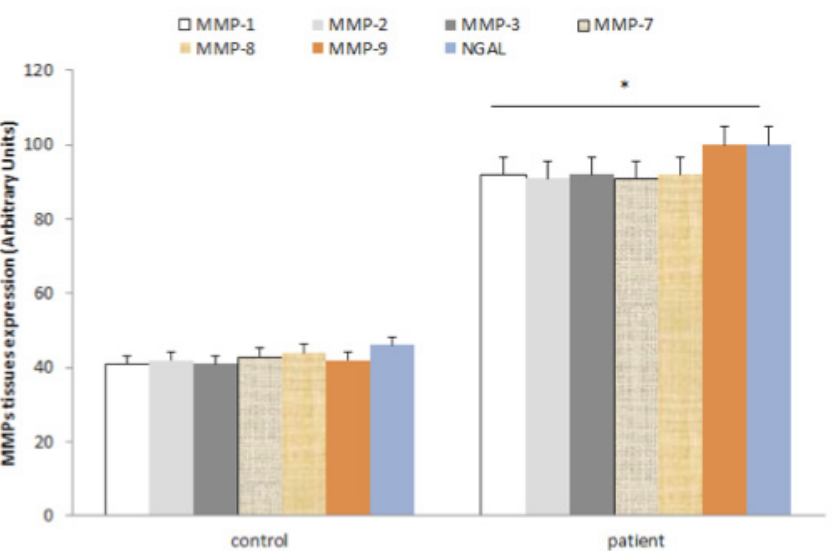
Figure 7: MMP-s and NGAL tissue expression in healthy and in aneurysmatic segments of the patient measured through western blot analysis on the tissues taken from abdominal aortic artery aneurysm at the time of the surgery. *P<0.01.